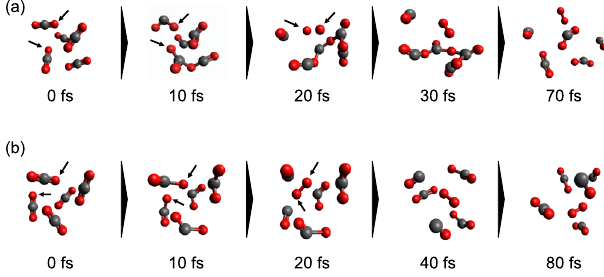
Fig. 3 Snapshots of molecular dynamics trajectories. Starting from a ð CO Þ 2 þ cluster leading to the formation of CO þ 2 5 formation of a covalently-bonded structure and b through O + /CO + . The arrow indicates the site of subsequent bond formation in each